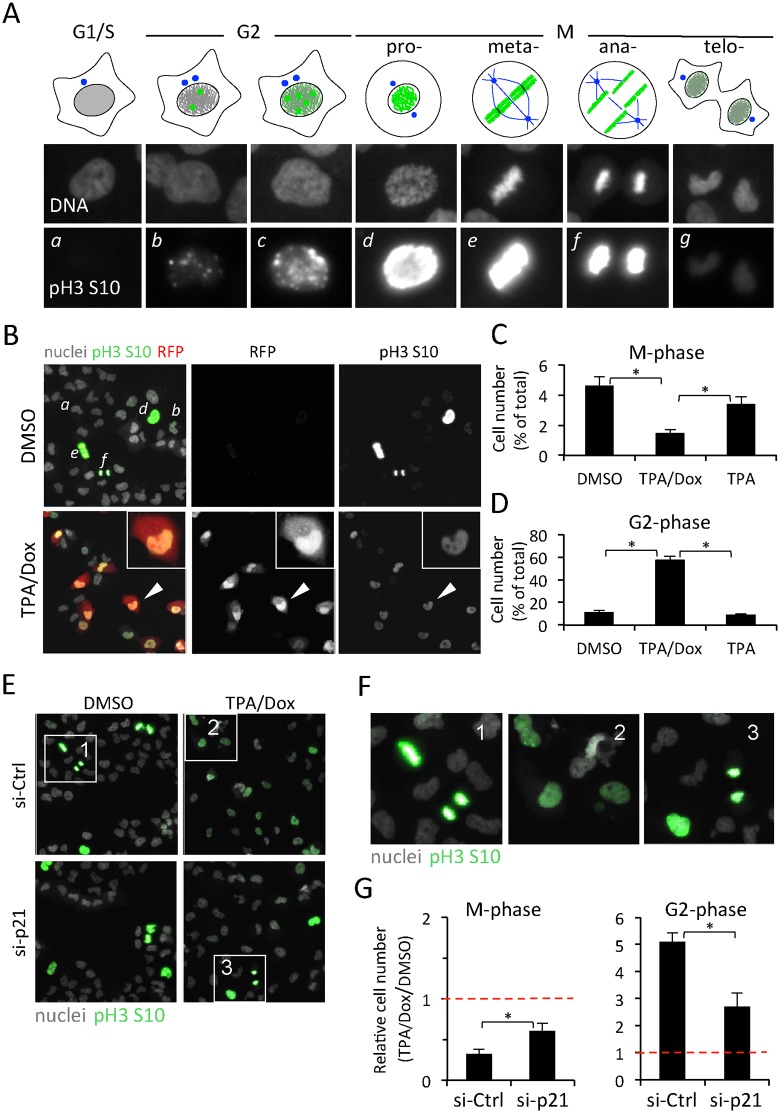
KSHV reactivation in iSLK.219 cells induces a G2 cell-cycle arrest.(A) Development of a high-content, image-based cell-cycle progression analysis based on the levels of phosphorylation of the histone H3 on serine-10 (pH3-S10). Automated image analysis was used to quantify the fluorescence intensity of each nucleus after immunofluorescence staining of pH3-S10, and to assign the corresponding cell to a specific stage of the cell cycle (a for G1/S, b-e for G2 or f-g for M). (B) Representative images of iSLK cells treated with DMSO or TPA/Dox for 20h and analyzed for cell cycle progression by pH3-S10 staining (green) and reactivation by RFP (red). Italics letters indicate different stages of the cell cycle (compare to (A)). The inset shows a magnification of the cell pointed by the white arrow head. (C-D) Quantification of the number of cells in M- (C) or G2-phase (D) in iSLK.219 cells treated with DMSO, TPA/Dox or TPAas. Values are the mean and SD of three independent experiments. The total number of cells in each sample was set as 100%. In each repetition, more than 1800 cells were analyzed. * p<0.05. (E) Images of pH3-S10 in iSLK.219 cells transfected with siRNAs against p21 (si-p21) or non-targeting controls (si-Ctrl), and reactivated with TPA/Dox for 20 hours. (F) Higher magnification images of cells in the respective white-box areas in panel (E). (G) Quantifications of the number of cells in M- or G2-phase in iSLK.219 cells treated as in (E). Values are normalized to the respective non-induced (DMSO) controls set to one (dotted red line). Error bars represent the SD of three independent experiments. * p<0.05.